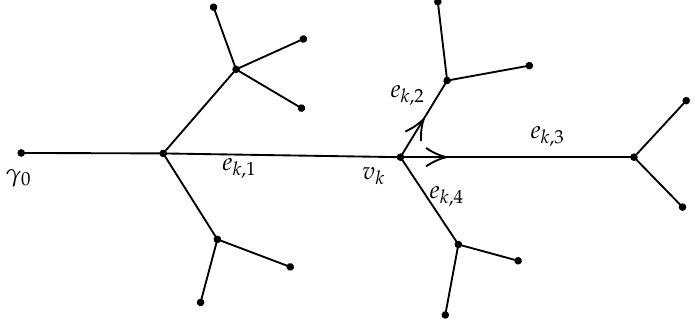
Figure 2. Sensors at vertex v k marked by